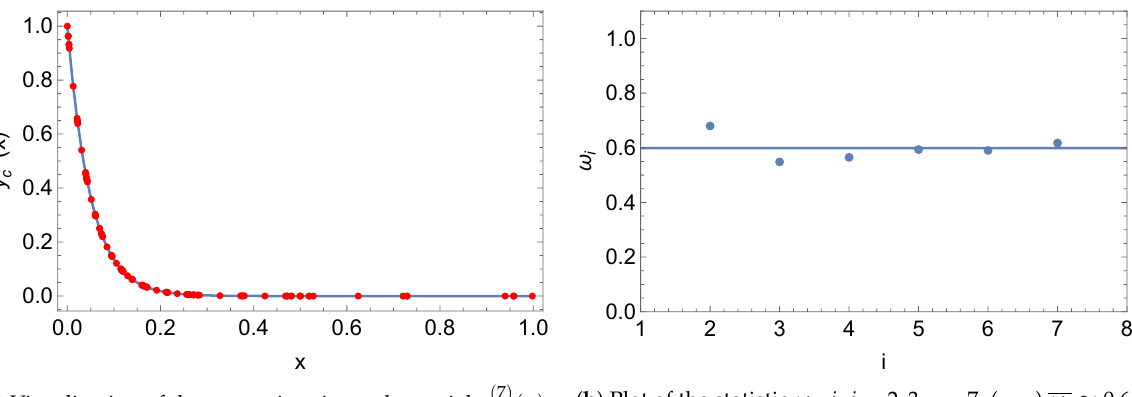
( b ) Plot of the statistic ω i , i , i = 2,3, . . . ,7. ( ) ω i ≈ 0.6. ( 7 ) ( x ) . A proper subset of the set of points S is shown. c